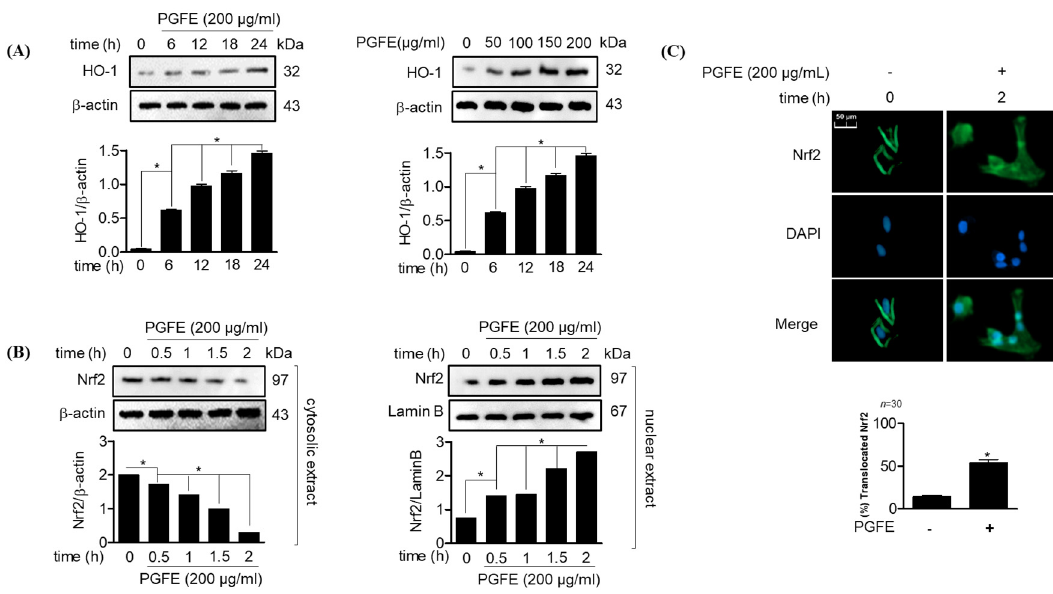
Figure 2. Effects of PGFE on heme oxygenase (HO)-1 induction and the promotion of nuclear factor-erythroid 2-related factor 2 (Nrf2) in HPDL cells. ( A ) The cells (1 × 10 6 cells/mL) were treated with 200 µg/mL for the indicated time (0, 6, 12, 18, 24 hr) or with the indicated concentrations of PGFE (50, 100, 150, and 200 µg/mL) for 24 hr. ( B ) The translocation of Nrf2 was analyzed by Western blot analysis from cells treated with 200 µg/mL of PGFE. ( C ) After treatment with the indicated concentration of PGFE within 2 hr, Nrf2 immunostaining was performed to confirm translocation. * p < 0.05 vs. each treated group. Scale bars denoted 50 µm.